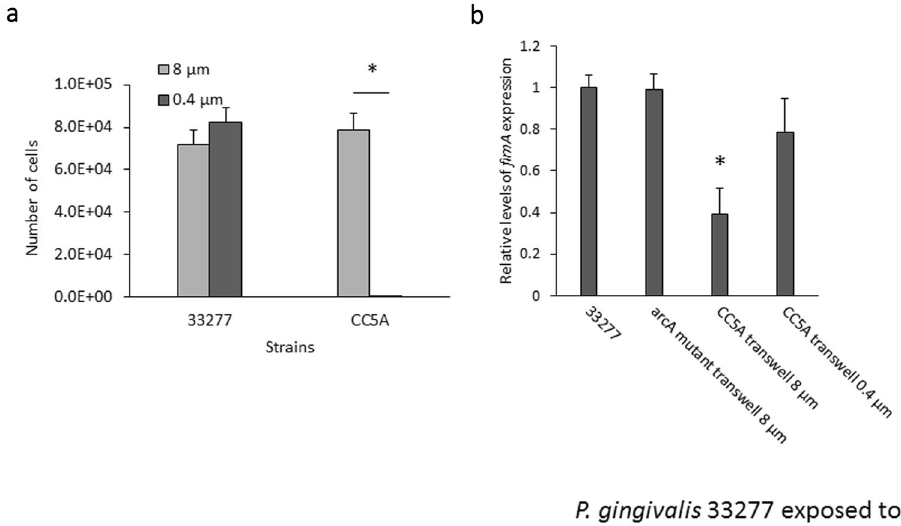
Figure 1. Expression of fimA in P . gingivalis in contact with S . cristatus . ( a ) S . cristatus CC5A migration through the Transwell insert. CC5A (1 × 10 7 cells) were initially incubated in the Transwell insert, and the numbers of CC5A migrated to the lower well and 33277 cells in the well were determined by qPCR. Each bar represents the number of bacteria detected in the lower well. Asterisk indicates a statistically significant difference in number of bacteria in the lower wells (n = 3; t test; p < 0.05). ( b ) Expression of the fimA gene in P . gingivalis in transwell chambers with S . cristatus was measured by real-time qRT-PCR. Each bar represents relative expression level of the fimA , which was normalized to that of 16 S rRNA gene. Standard deviations are indicated. Asterisk indicates a statistically significant difference in expression level of fimA compared to that in P . gingivalis without exposure to S . cristatus (n = 3; t test; p <